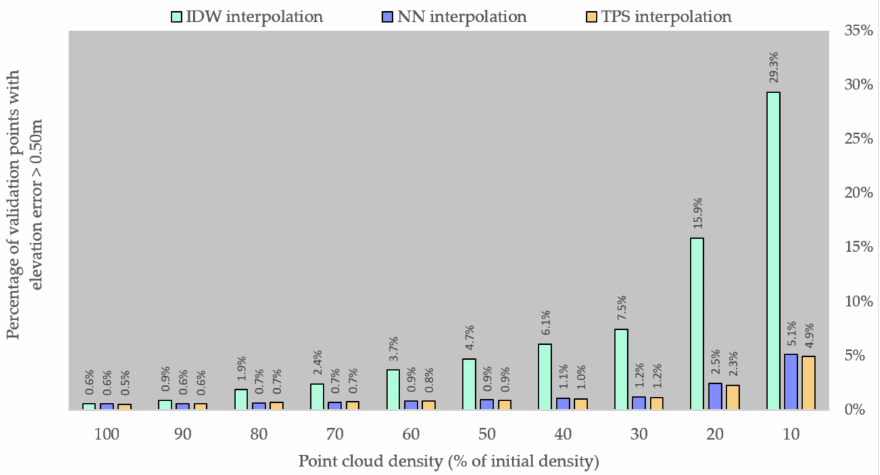
Figure 7. Percentage of validation points with an elevation error over 0.50 m.